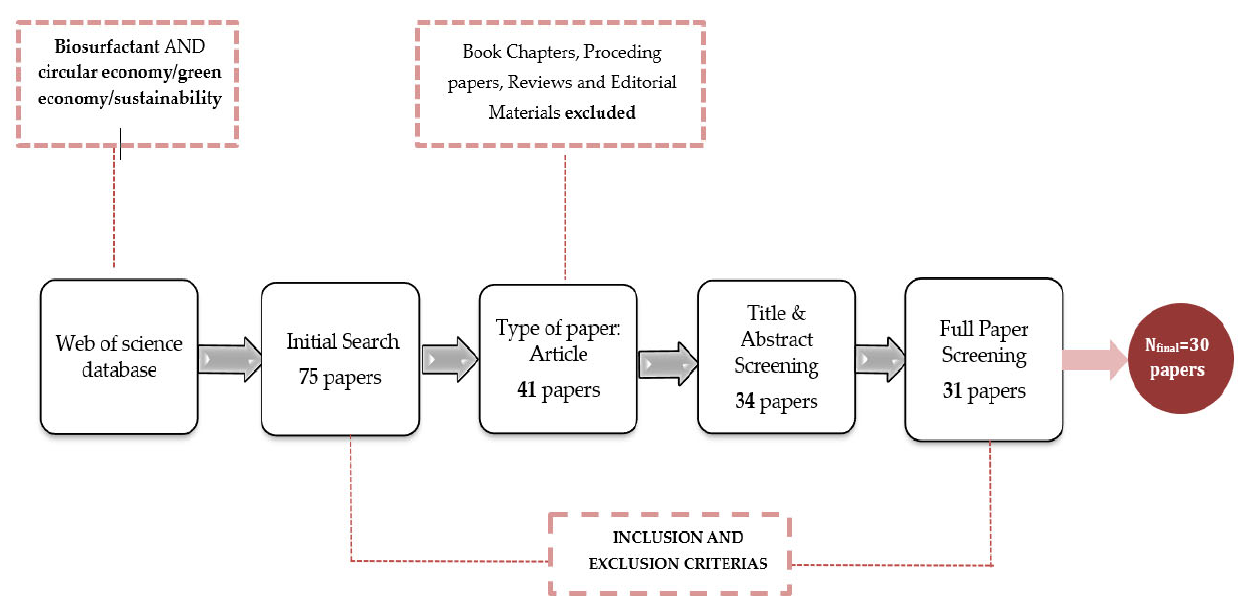
Figure 2. Methodological approach.